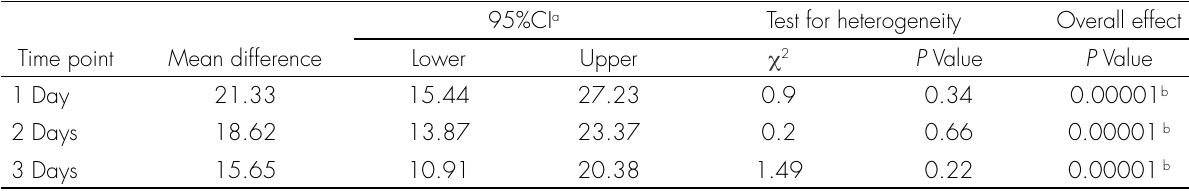
Supplementary Figure 4. Structured phone call follow-up and control for meta-analysis results, Table III. Meta-analysis data summary: Cognitive behavior therapy (CBT) vs control group. reported in mean difference (95% confidence interval), show evidence favouring structured